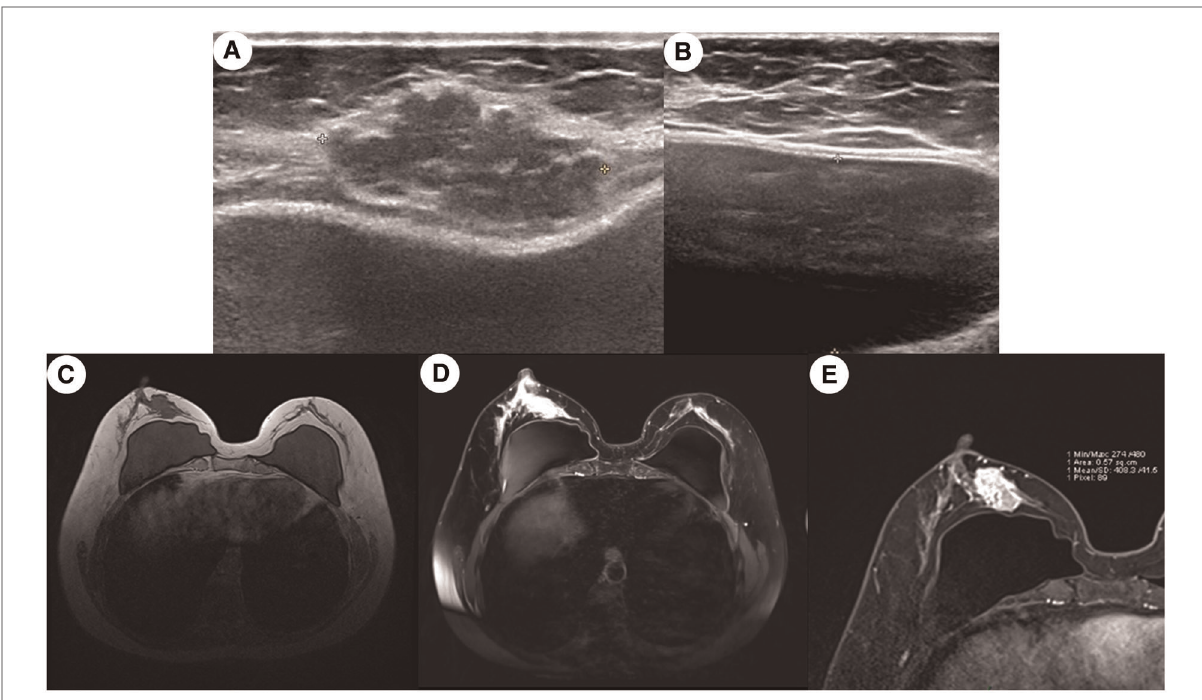
FIGURE 1 Medical imaging presentation of the breast mass. ( A ) Ultrasound image of a mixed-density multilobulated mass subcutaneous to the breast of an irregular shape and uneven margin; ( B ) ultrasound image of the pocket of breast prosthesis; ( C ) MRI image of the breast showing a lobulated mass in the right inner quadrant was adjacent to the margin of the prosthesis, and the vessels were increased and thickened; ( D ) contrast- enhanced MRI imaging showing that several early enhanced small nodules were seen in the upper posterior area of the tumor and the diffusion was limited, which seems like the satellite lesion of the tumor; ( E ) enlargement of the image in ( D) . The capsule of the prosthesis was wrinkled, and the edge of the prosthesis presented the change of chronic in fl